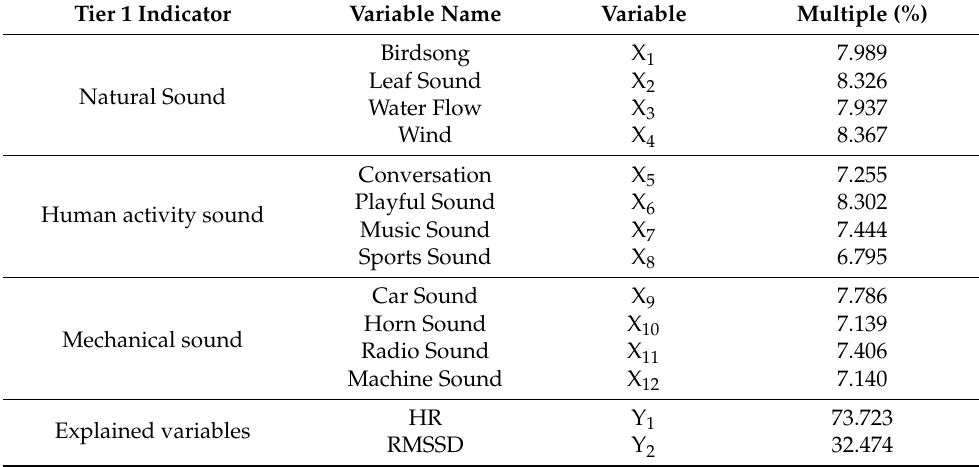
Table 9. Data descriptive statistics for multiple linear regression analysis.